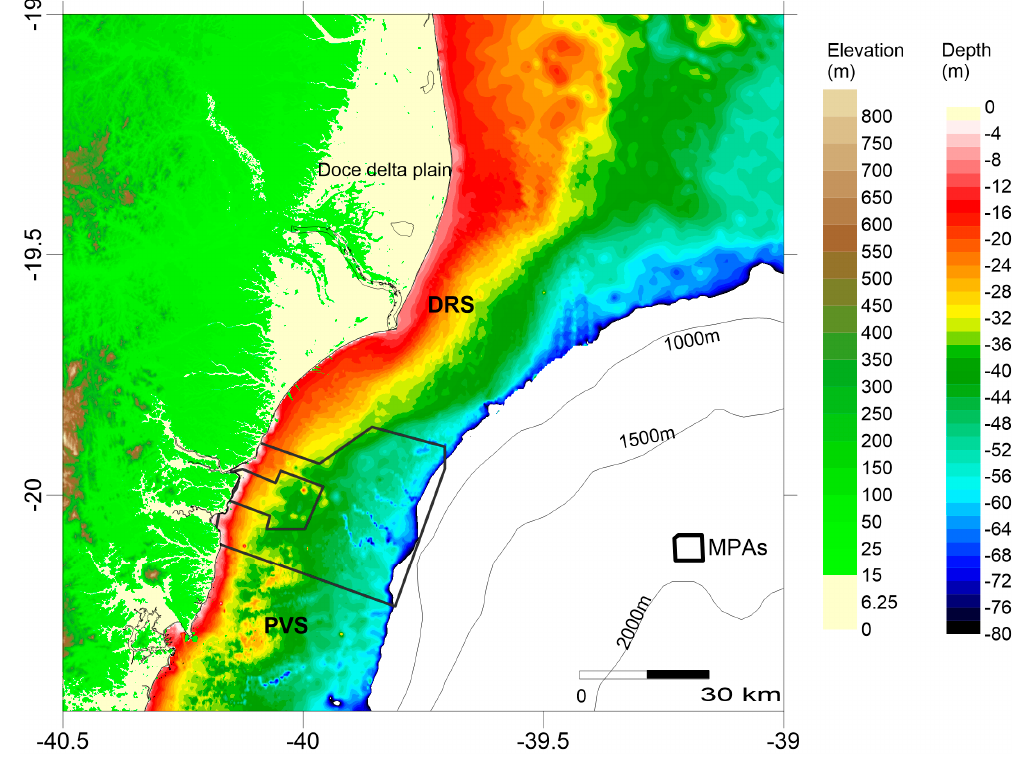
Figure 2. Digital Terrain model of the study region. Continental data was obtained from Topodata database (http://www.dsr.inpe.br/topodata/), and bathymetrica data was digitized from sounding sheets provided by the Brazilian Hydrographic Office. The seabed morphology has a spatial resolution of 200m along the continental shelf. PVS: Paleovalley Shelf; DRS: Doce River Shelf. Datum is WGS 84.